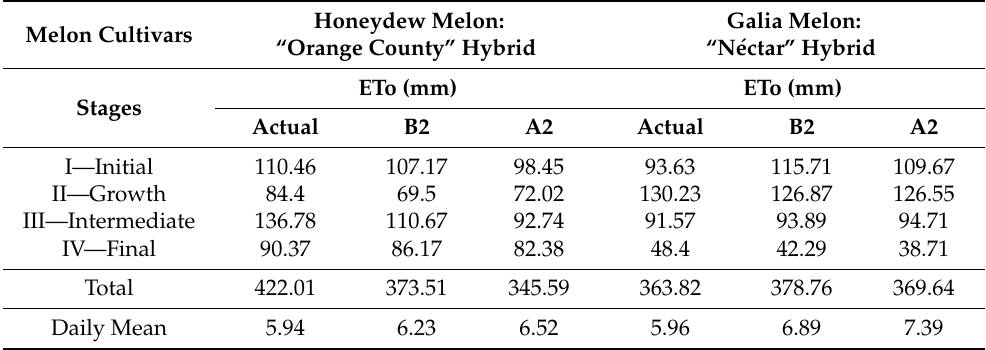
Table 4. Melon cultivars’ crop coefficient values (Kc) and reference evapotranspiration (ETo) for the Intergovernmental Panel on Climate Change’s emission